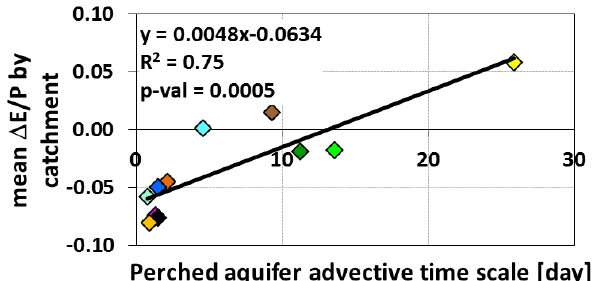
Fig. 6. Correlation between mean 1E/P by catchment and perched Figure 6 aquifer advective time scale (sample size: 12; p value: 0.001).